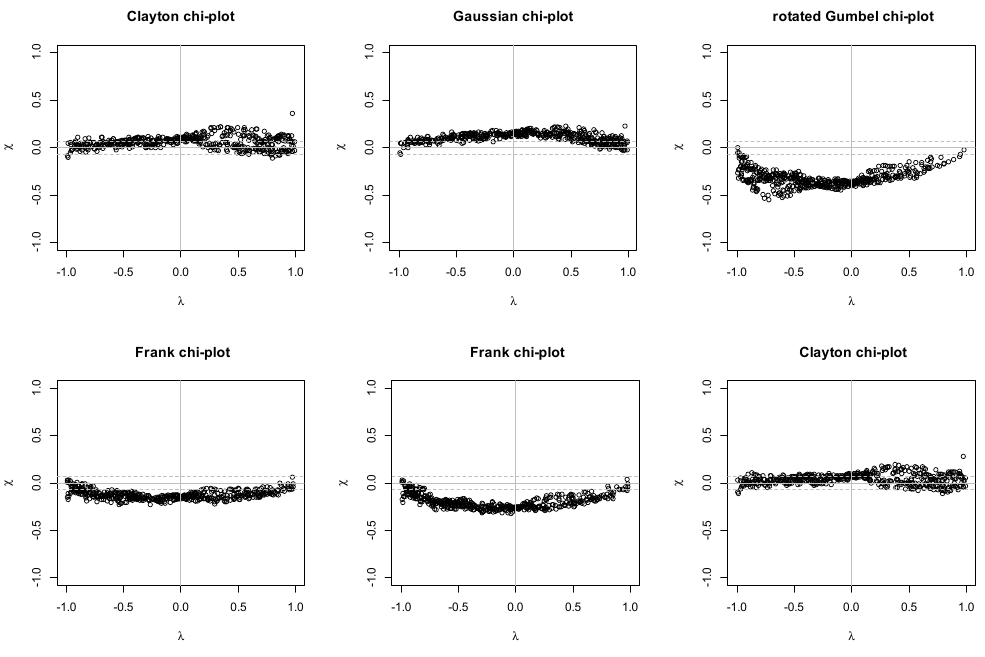
Figure 8. Chi-plots of pair flood volume variables of Zhangjiashan and Huaxian County. Figures 9–11 present the K-plots of pair flood volume variables. All points are also random variables that obey the corresponding copula distribution. Figure 9 shows the K- plots of pair flood volume variables for Zhangjiashan and Xianyang (multi-reservoirs for 2,3). Random variables of the 1-day, 3-day, 5-day, 9-day, 12-day, and peak flood volumes obey the Gaussian, Clayton, Gaussian, Gaussian, Rotated Joe, and Gaussian distributions, respectively. A deviation is observed from the centre of the main diagonal, indicating a positive association between the two sites. Figure 10 shows a positive association between Xianyang and Huaxian County (multi-reservoirs for 1,2). Random variables of the 1-day, 3-day, 5-day, 9-day, 12-day, and peak flood volumes obey the Gaussian, Gaussian, Gauss- ian, Gaussian, Gaussian, and Clayton distributions, respectively. Random variables of the